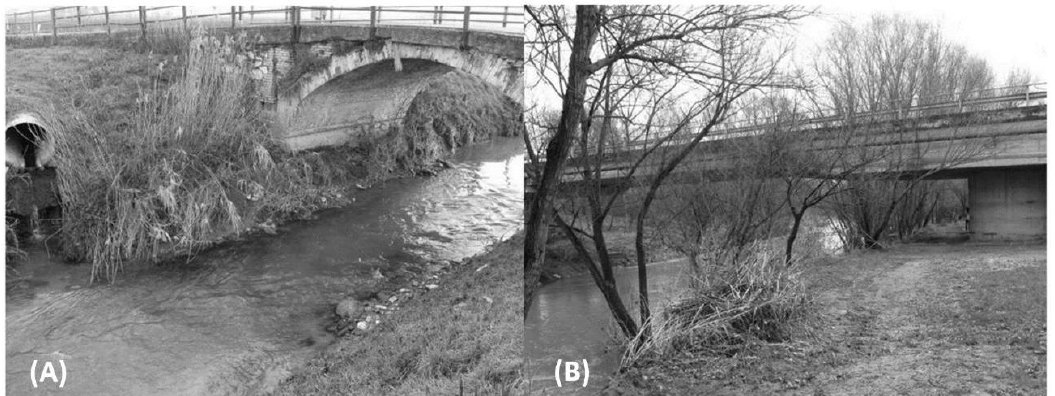
Figure 7. Example of bridges with different structural and dimensional characteristics: small masonry arch bridge ( A ); bridge with a large beam in reinforced concrete ( B ).